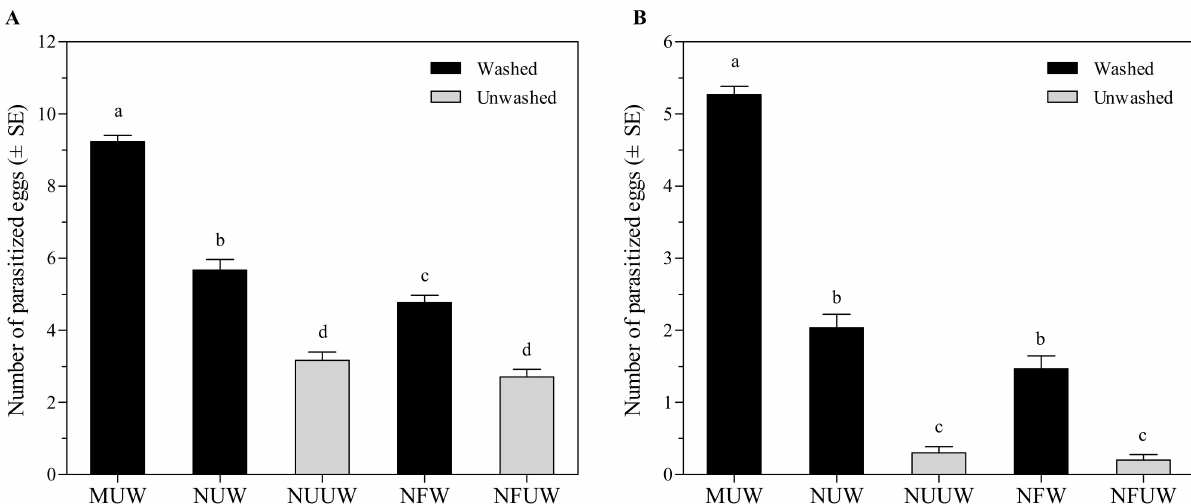
Figure 1. Number of parasitized Antheraea pernyi eggs by Aprostocetus brevipedicellus with different treatments in no-choice test ( A ) and the choice test ( B ). MUW: manually-extracted, unfertilized and washed eggs; NUW: naturally-laid, unfertilized and washed eggs; NUUW: naturally-laid, unfertilized and unwashed eggs; NFW: naturally-laid, fertilized and washed eggs; NFUW: naturally-laid, fertilized and unwashed eggs. In the no-choice test, different lower-case letters on top of bars indicate significant differences among egg treatments based on Tukey’s multiple comparison (HSD) test ( p < 0.05). In the choice test, different lower-case letters on bars indicate significant differences among egg treatments based on Friedman’s significant difference test ( p <